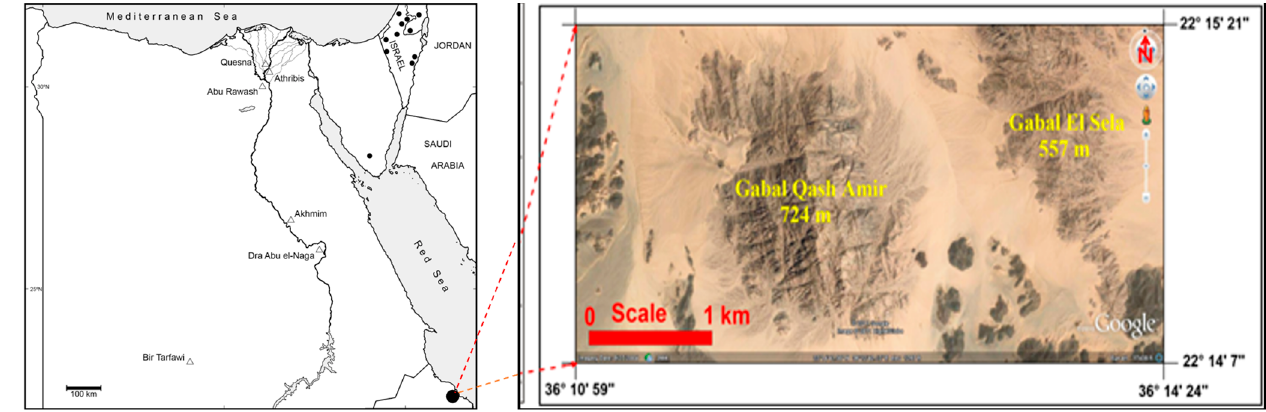
Figure 1. Location map and Google image for the Gabal Qash Amir area. The study location forms an isolated ovoid pluton with intruding schistose